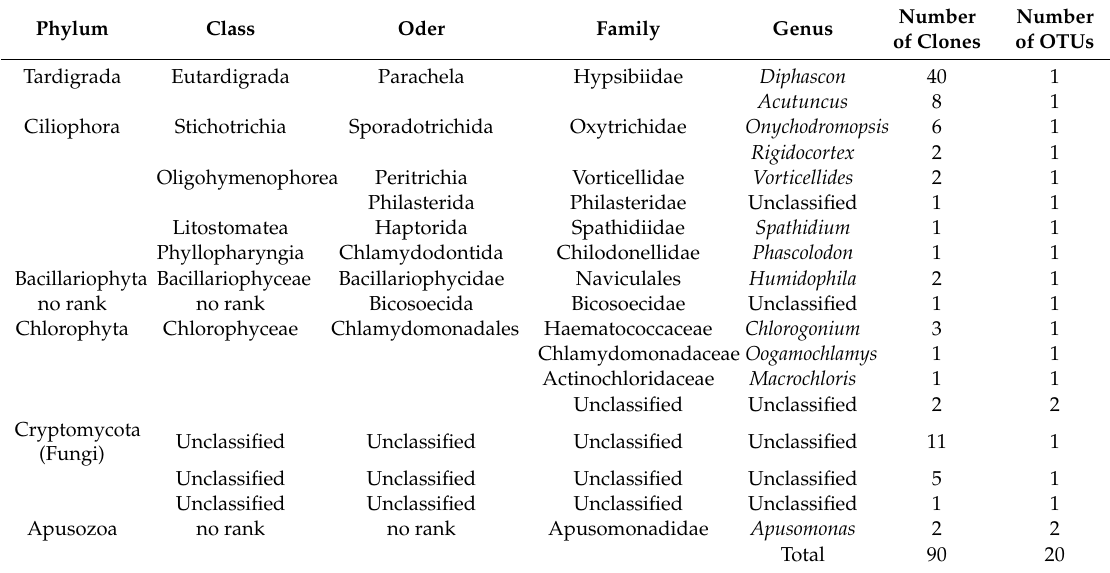
Table 3. List of eukaryotic clones.